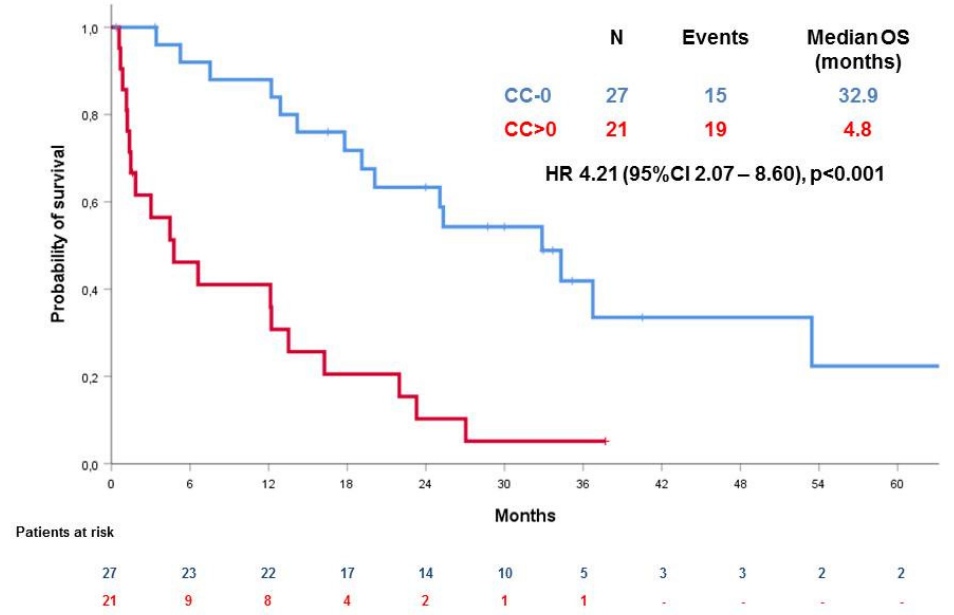
Figure 2. Overall survival (OS) according to residual disease (CC-0 versus not).